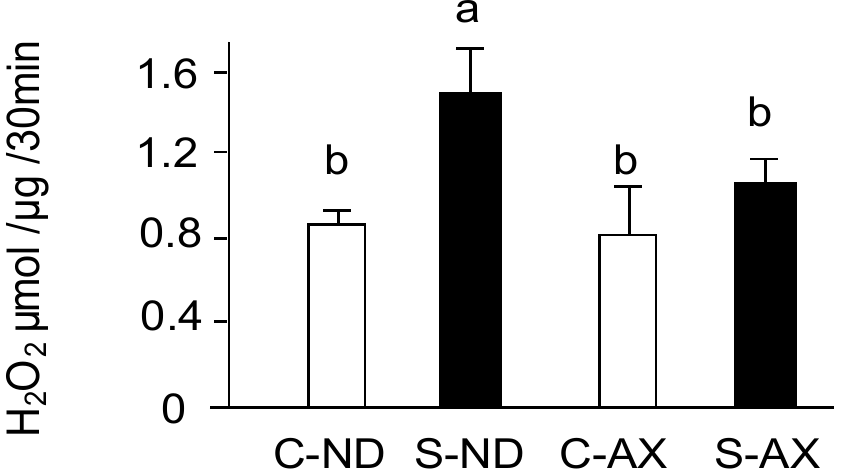
Figure 4. Effect of dietary AX on H 2 O 2 production in the muscle of tail-suspension mice. The rate of H 2 O 2 production from isolated mitochondria in muscle was detected by Amplex Red fluorescence. Data are represented as mean ± S.D. ( n = 6). Different letters indicate significant differences ( p < 0.05) based on the one-way ANOVA and Tukey’s test. C-ND, control mice fed the normal diet; S-ND, tail-suspension mice fed the normal diet; C-AX, control mice fed the AX-supplemented diet; and S-AX, tail-suspension mice fed the AX-supplemented diet. H 2 O 2 production are representative of at least three independent studies.